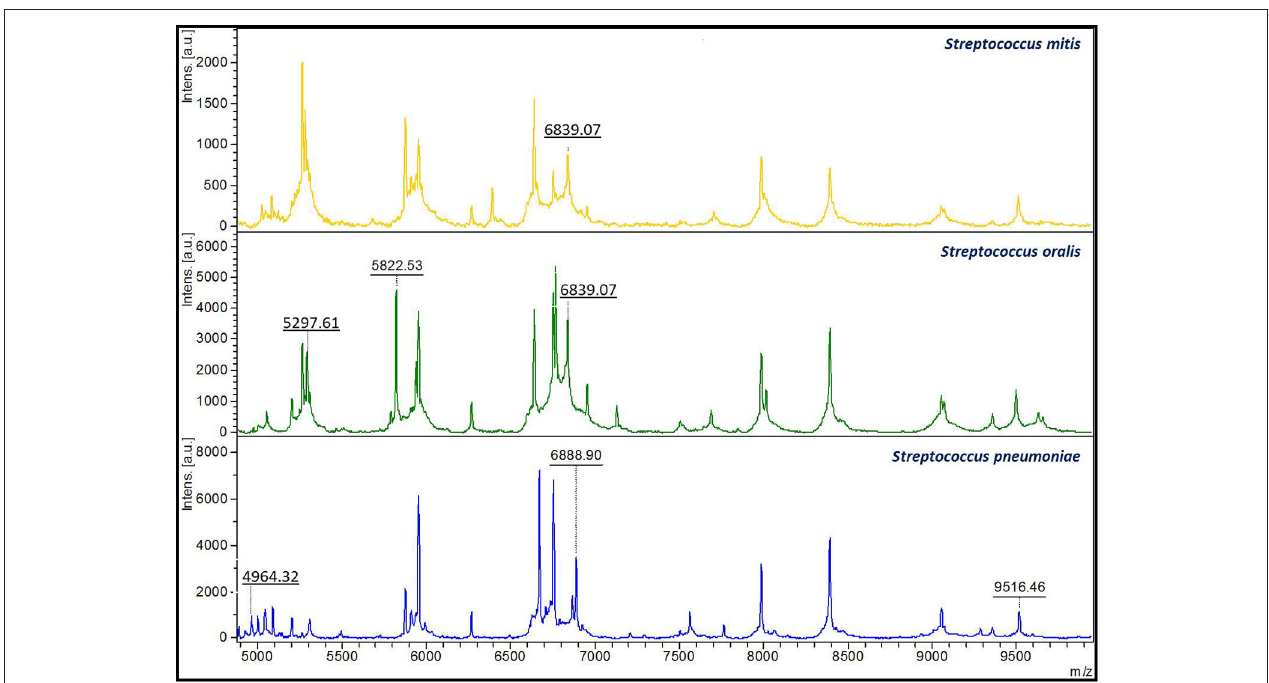
FIGURE 1 | Distinctive species-specific peaks present in close related Streptococcus species. The 6,839.07 m/z has been shown to be present in protein spectra from S. mitis isolates (above). This peak is also present in S. oralis spectra (middle) in combination with the 5,297.61 and the 5,822.53 m/z peaks. On the other hand, S. pneumoniae isolates (bottom) showed three unique peaks of 4,964.32, 6,888.90, and 9,516.46 m/z.